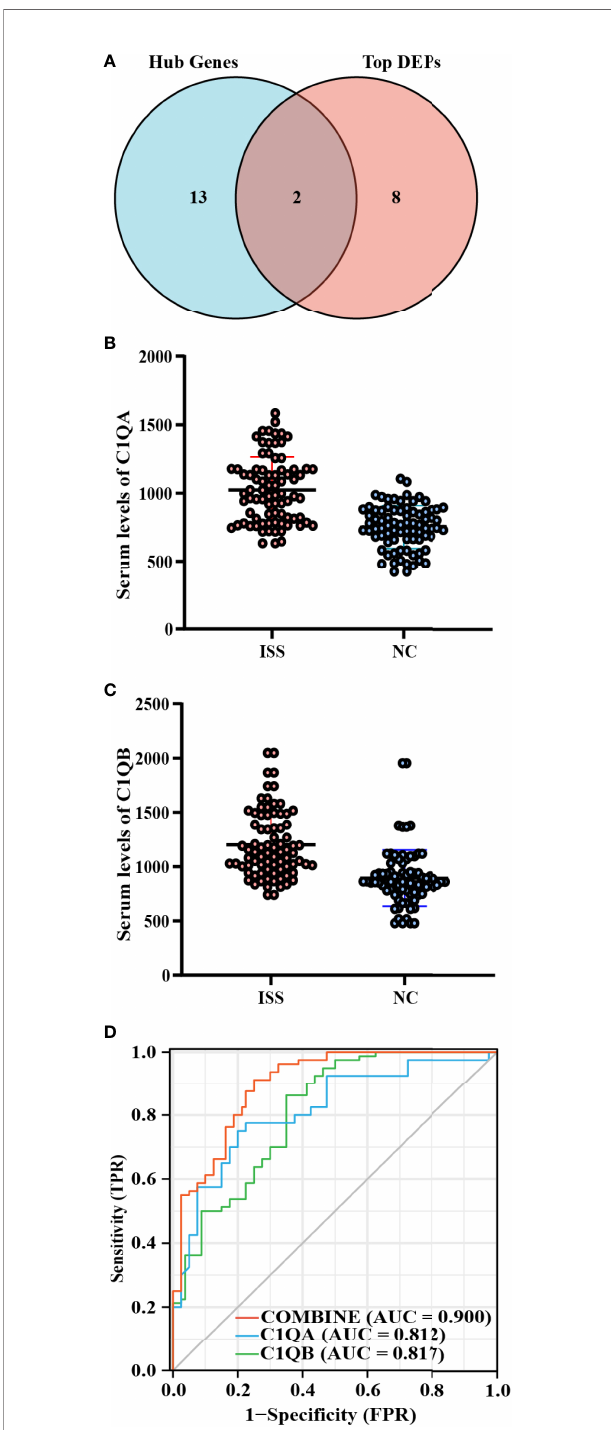
FIGURE 2 | Diagnostic model construction of ISS. (A) Venn diagram of intersected targets of Hub genes and the top 10 FC DEPs. The serum expression levels of C1QA (B) and C1QB (C) between ISS and control groups, FC = XXX, P < 0.05. (D) Receiver operating characteristic (ROC) for predictive values of C1QA (blue), C1QB (green), and combined (red) levels in detecting